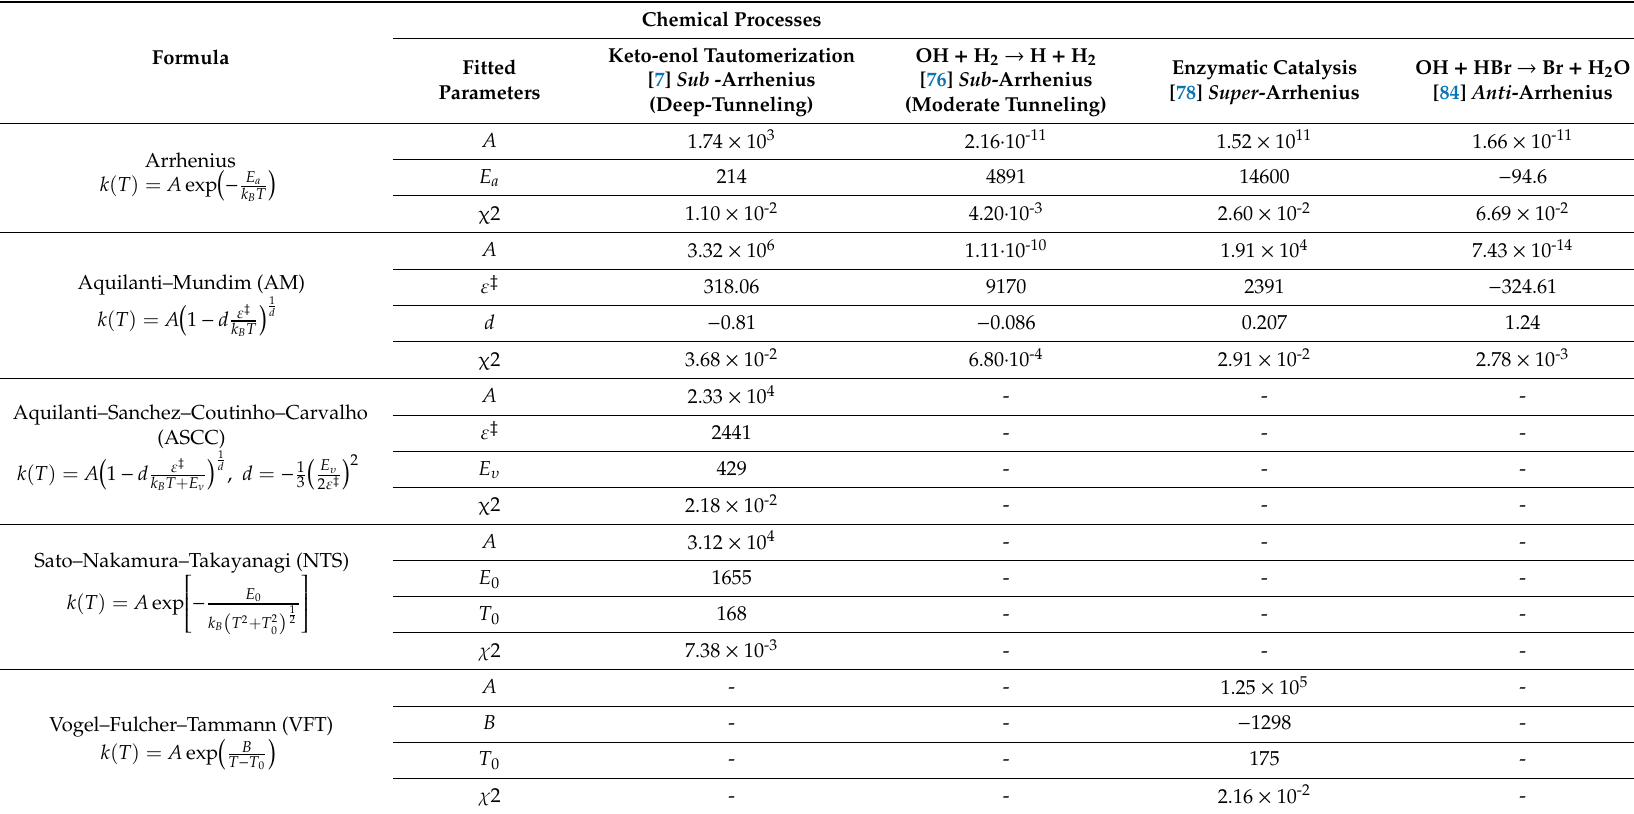
Table 1. Fitted parameters for the Arrhenius, AM, ASCC, NTS and VFT formulas, using the Transitivity code for keto–enol tautomerization [7], OH + H 2 [76], enzymatic catalysis [78] and OH + Br [84] reactions. Energy ( E a , ε ‡ , E υ and E 0 ) is in cal / mol and temperature ( T 0 and B ) in K. Pre-factor units can be identified in the